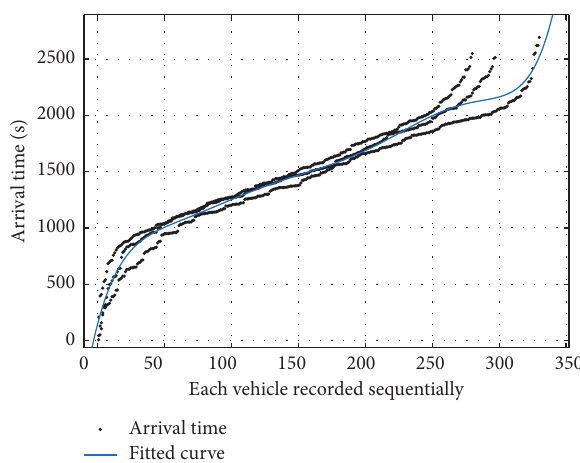
Figure 3: Three days’ vehicle arrival time fitting graph.